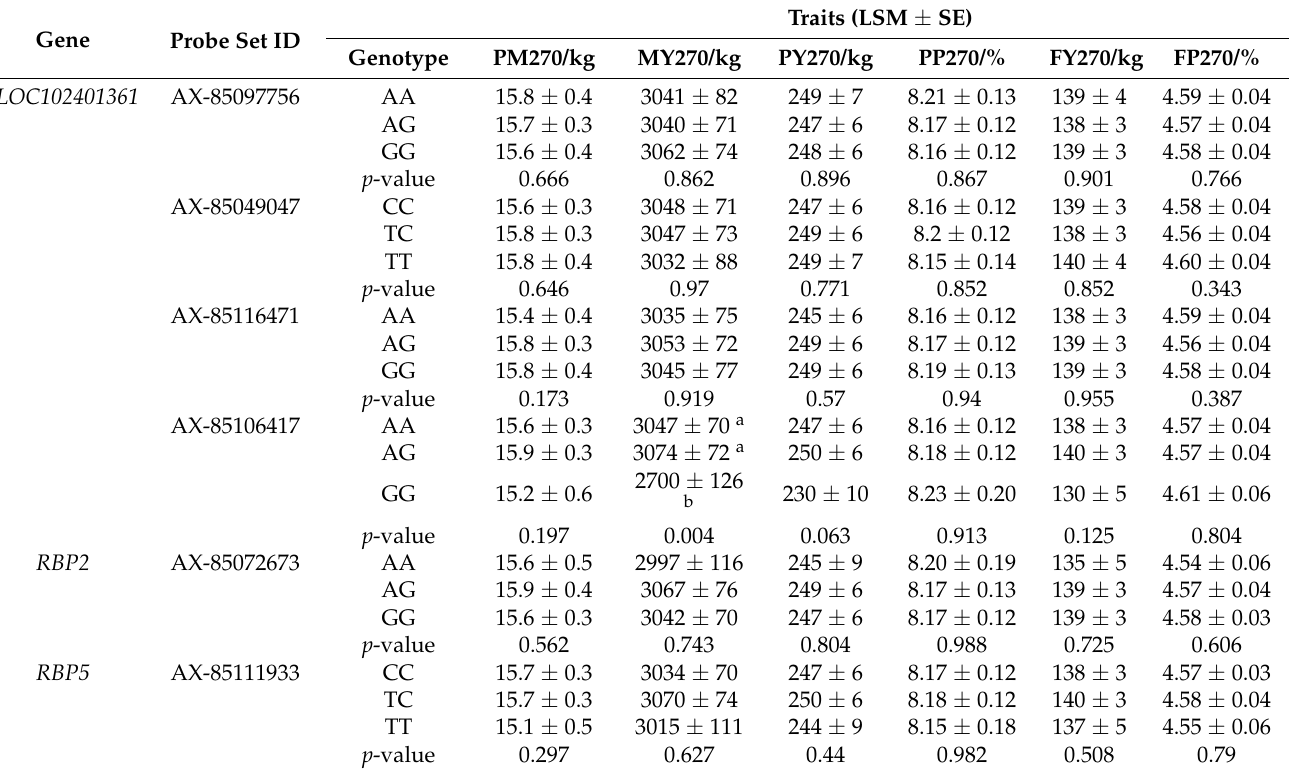
Table 5. SNP association analysis for six milk production traits in